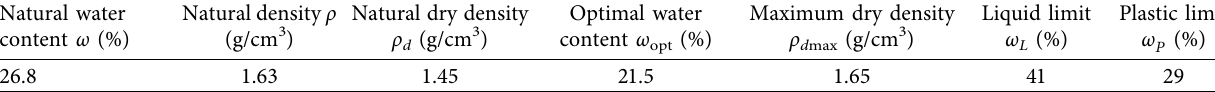
Table 1: Physical properties of expanded soil samples.